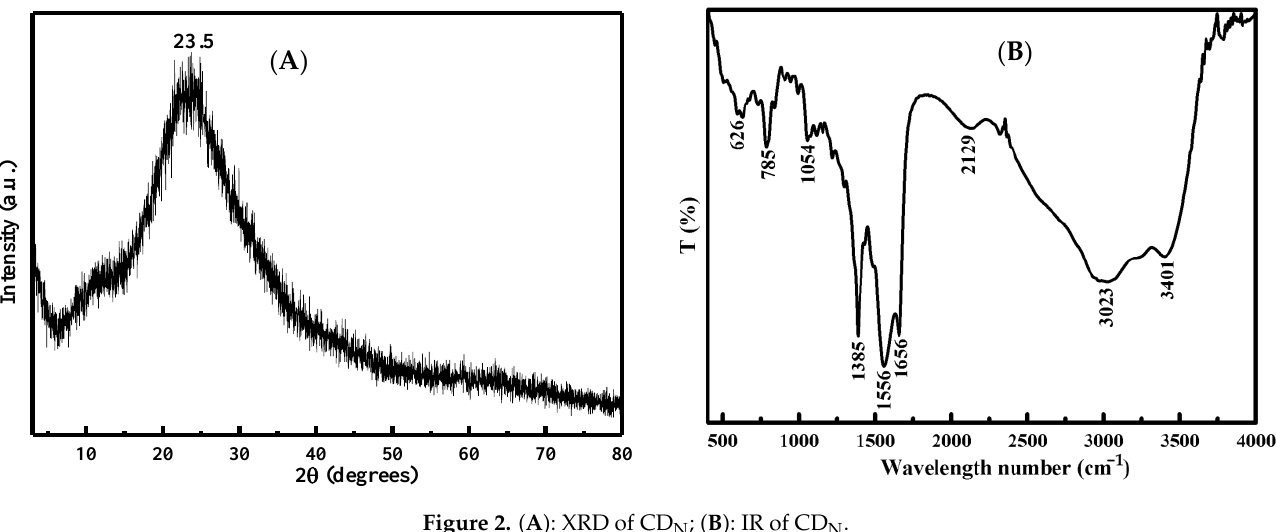
Figure 2. ( A ): XRD of CD N ; ( B ): IR of CD N .